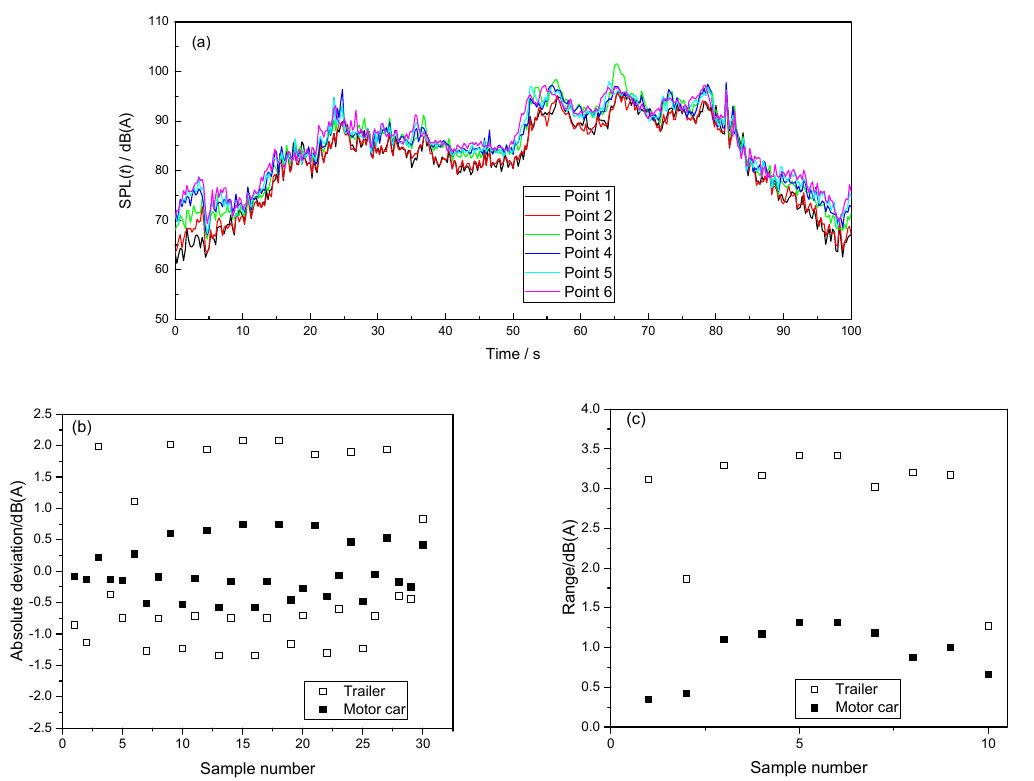
Figure 9. Measurement error analysis: ( a ) a typical running SPL( t ) of a metro section between two stations, ( b ) the absolute deviations of the ten tested metro sections, and ( c ) the ranges of the ten tested metro sections.